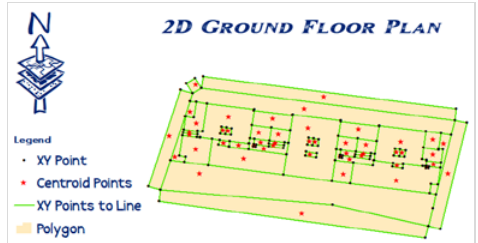
Figure 3. Ground floor 2D plan with bounding points, bounding lines, polygon center points and polygons (ArcMap)